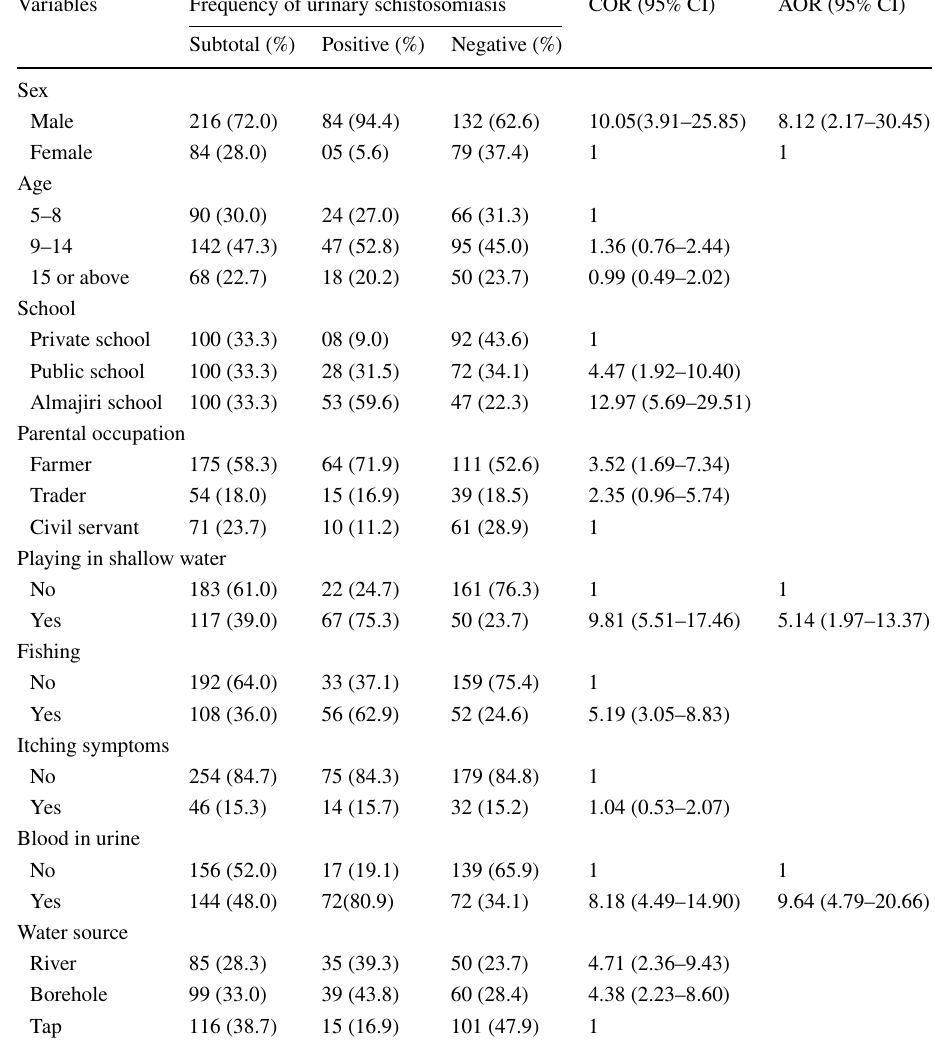
Table 3 Bivariate and multiple logistic regression analyses of variables associated with risk factors for urinary schistosomiasis in the study